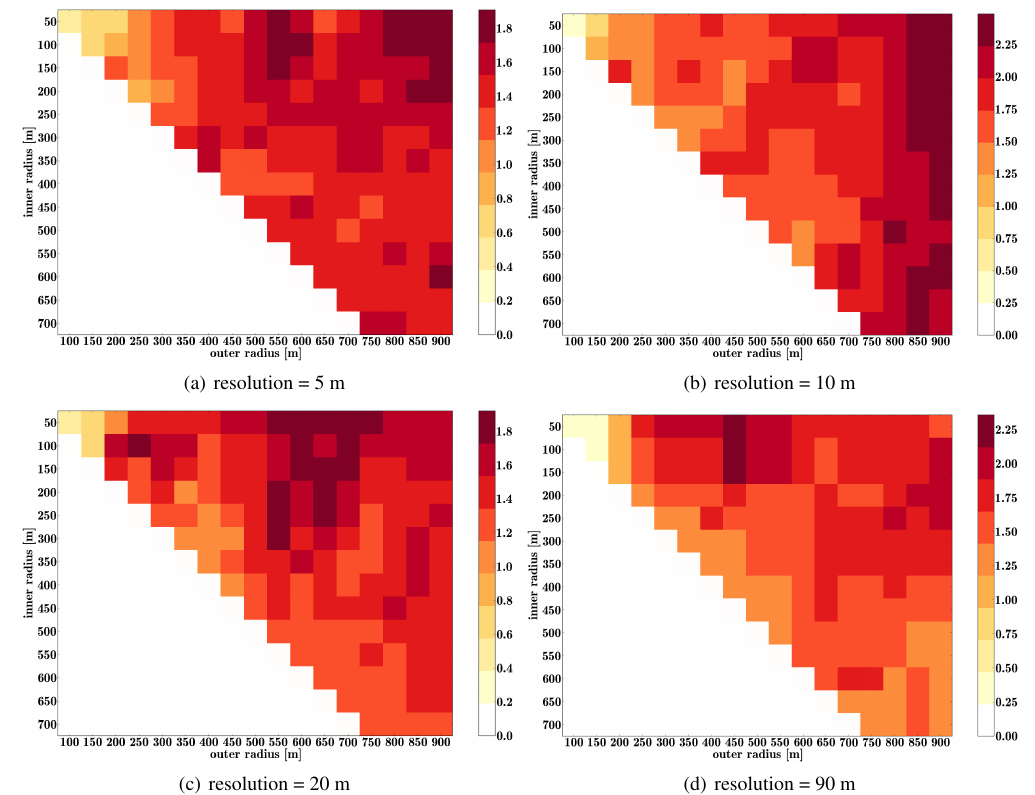
Figure 8: Variance in number of affected households per class [%] for different